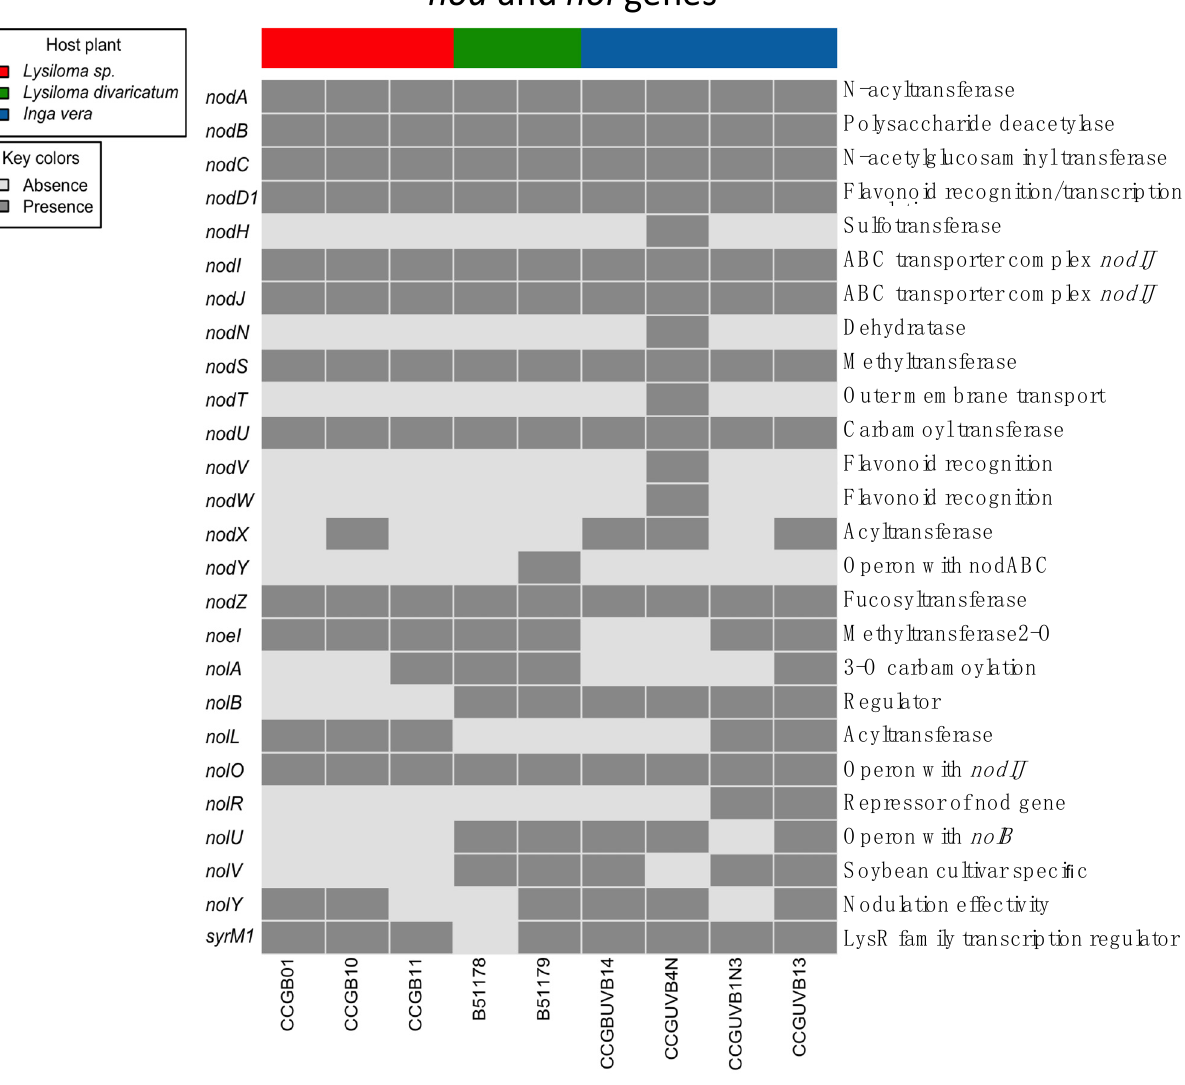
Figure 6. Comparative analysis of nodulation genes in the Lysiloma spp. and Inga vera Bradyrhizobium isolates. The top sidebar indicates the legume host: red for Lysiloma sp., green for L. divaricatum and blue for I. vera .